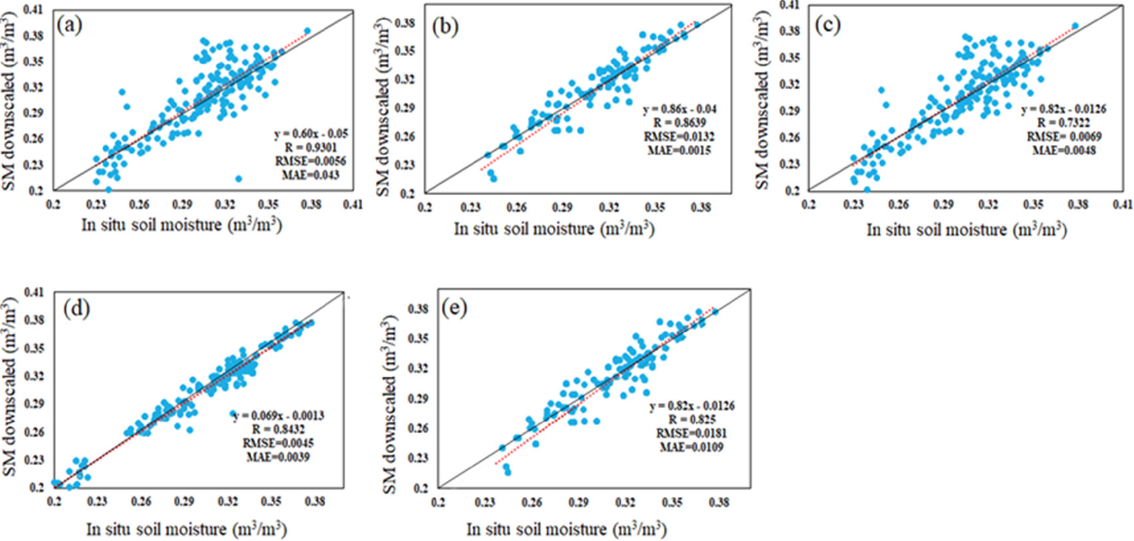
Figure 4. The R and RMSE between downscaled and in situ monthly observations of soil moisture (SM) (( a ): Kenya, ( b ): Namibia, ( c ): Sudan, ( d ): Senegal, ( e ): South Africa). Table 4. The analysis of the seasonal ground observations in the five countries. Region Validation Period